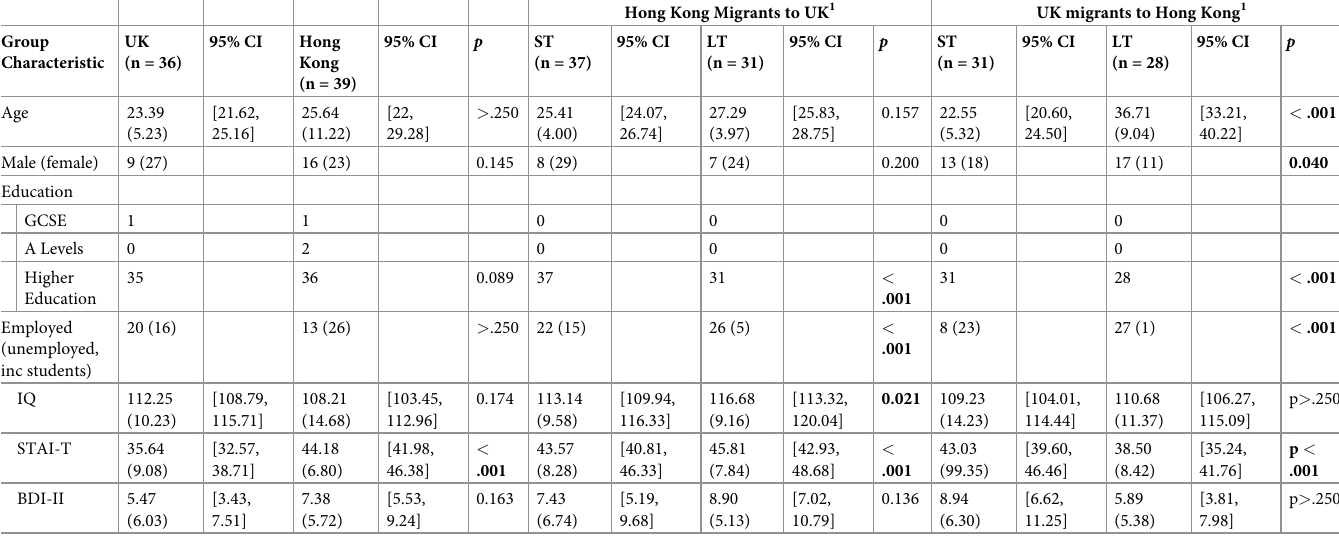
Table 1. Socio-demographic characteristics and individual difference measures for the sample. Mean (standard